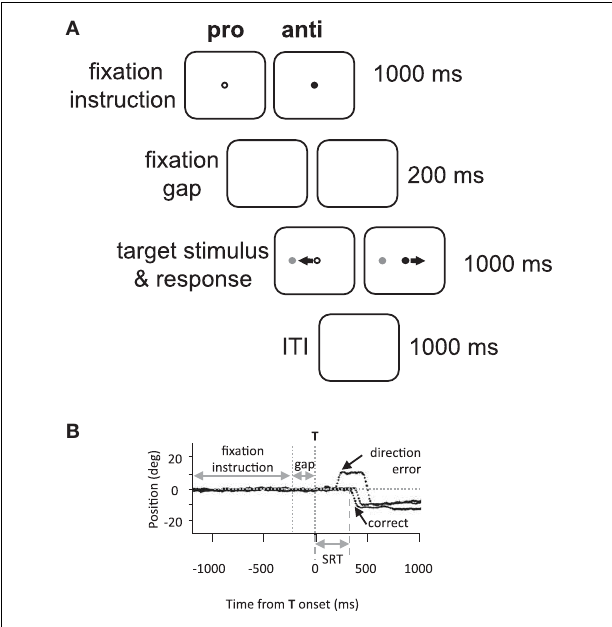
FIGURE 1 | Methods. (A) Experimental paradigm and timings of events. Anti, anti-saccade; ITI, inter-trial interval; pro, pro-saccade. (B) Illustration of eye position traces for correct leftward anti-saccade trials, and a direction error on an anti-saccade trial. SRT, saccade reaction time;T, target